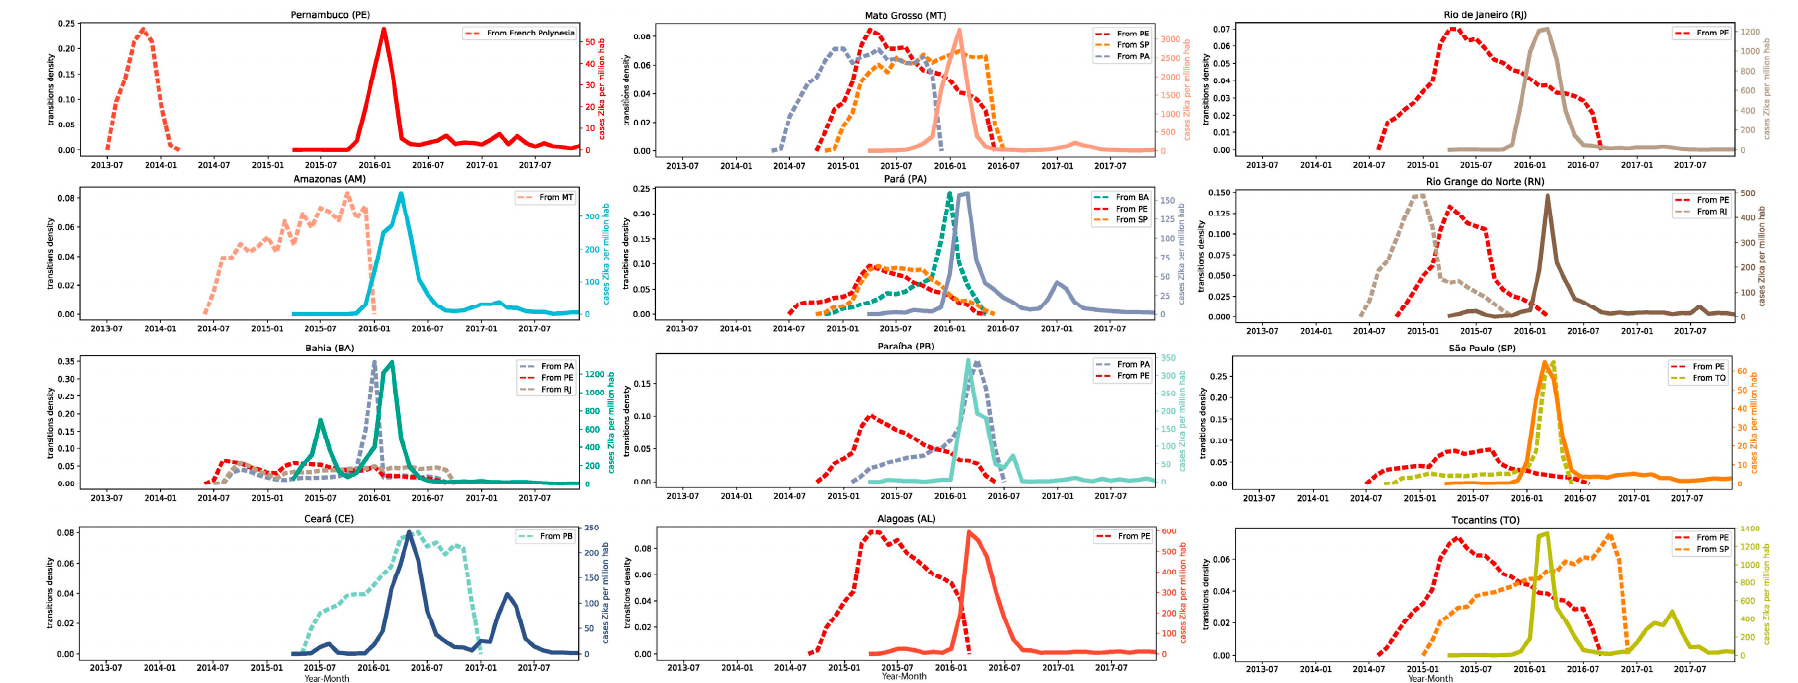
Figure 5. ZIKV transition dynamics between Brazilian states and epidemic history. Each panel shows the number of viral transitions through time, as estimated by Markov Jumps analysis, (dashed lines) colored according to the state of origin and the number of confirmed cases per million habitants (solid